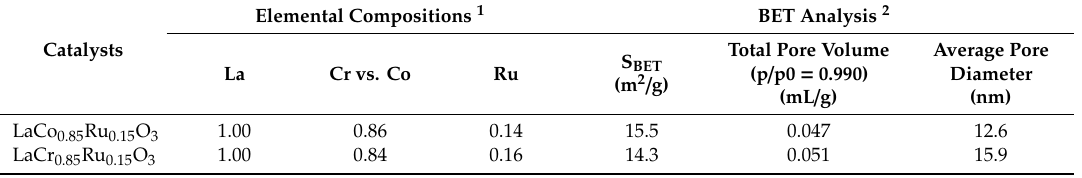
Figure 2. SEM image and EDX mapping images of ( a ) LaCr 0.85 Ru 0.15 O 3 and ( b ) LaCo 0.85 Ru 0.15 O 3 , including elemental analysis results. Table 2. Elemental and N 2 adsorption isomers analysis of LaCr 0.9 Ru 0.1 O 3 and LaCo 0.9 Ru 0.1 O 3 catalysts.